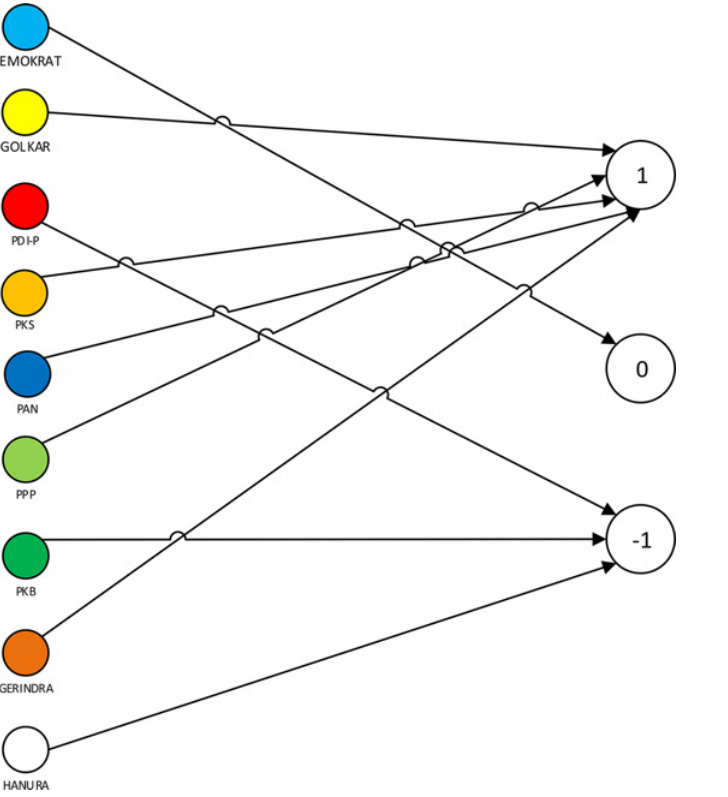
Fig 10. “ Approximate ” Flow Graph of Indonesian Parties.